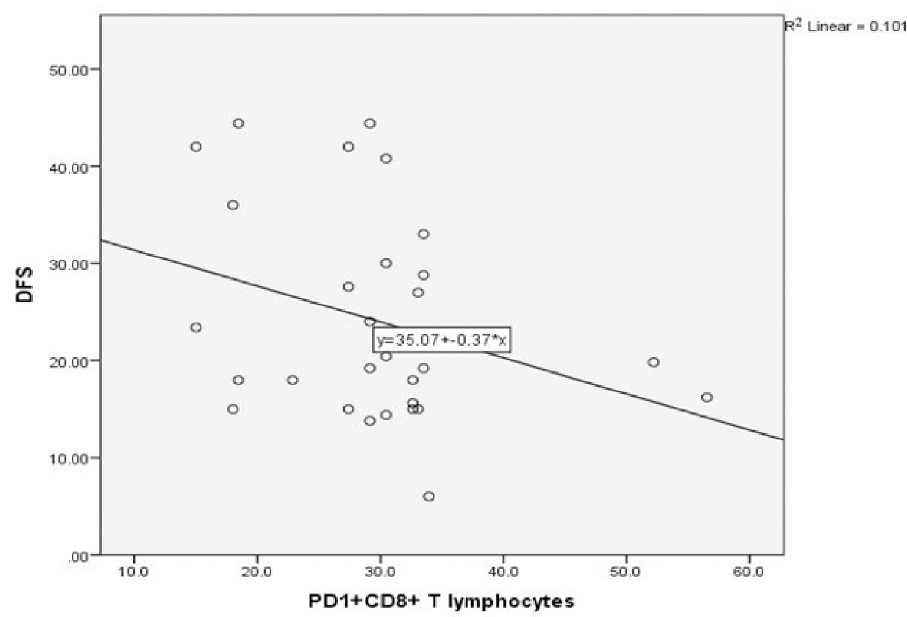
Fig 5. Correlation of peripheral PD1 + CD8 + T lymphocytes with DFS in 30 TNBC patients ( p = 0.04).